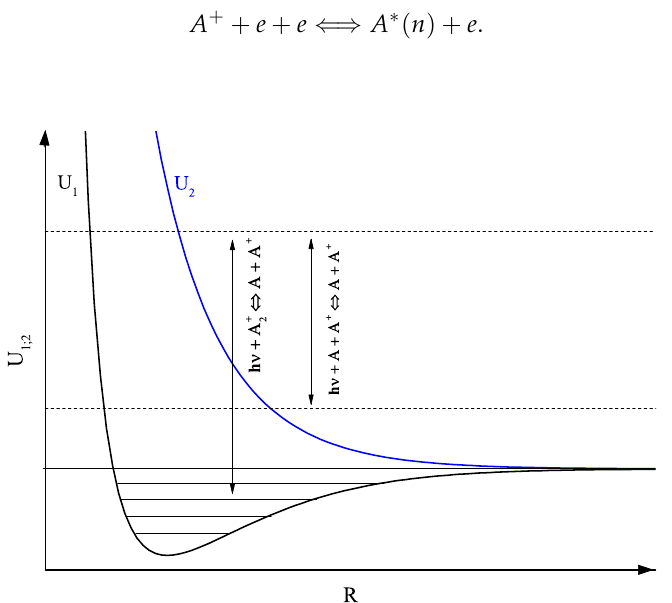
Figure 2. The schematic presentation of the photo-dissociation/association processes Equation (2a) and free–free processes Equation (2b): R is the internuclear distance, U 1 ( R ) and U 2 ( R ) are the potential energy curves of the initial (lower) and final (upper) electronic state of molecular ion A + photon energy.